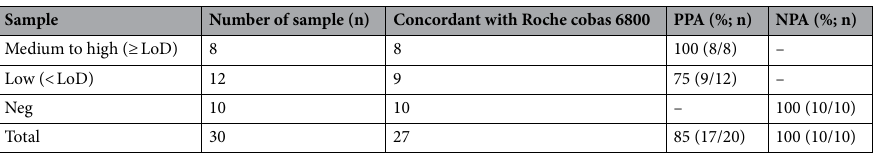
Table 2. Summary of direct RT-LAMP testing on clinical samples. PPA positive percentage agreement, NPA negative percentage agreement.